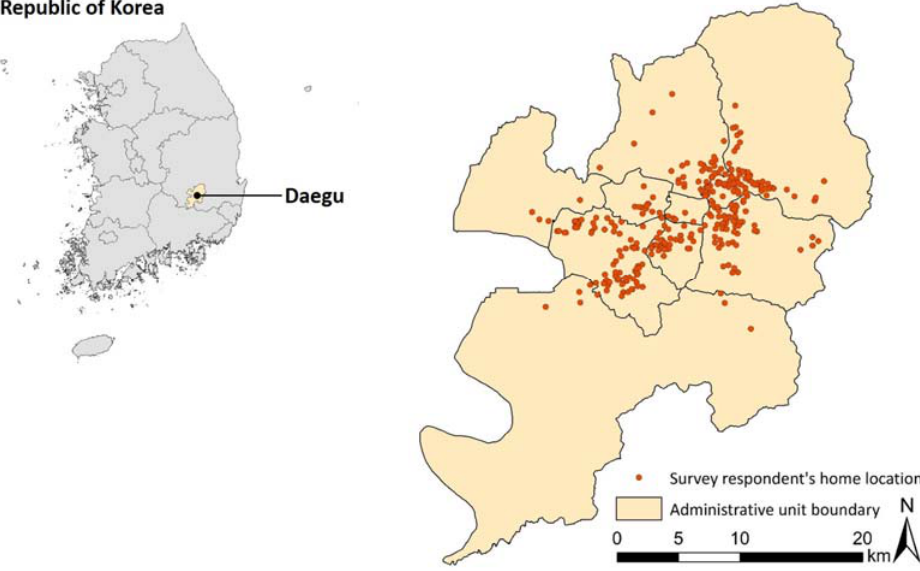
Figure 1. Research area and the survey respondent’s location.